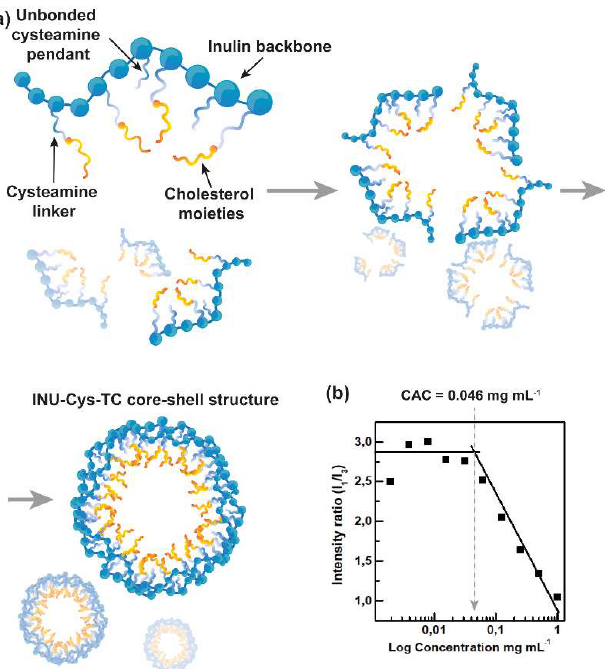
Figure 4. Representation of the self-assembling processes taking place during the formation of core-shell nanostructures ( a ). Pyrene assay analysis for CAC determination ( b ): the I 1 /I 3 ratio obtained from the emission spectrum of pyrene usually changes when in the presence of hydrophobic pockets due to the self-assembling of amphiphilic polymers. Atomic force microscopy (AFM) micrographs of dried INU-Cys-TC core-shell